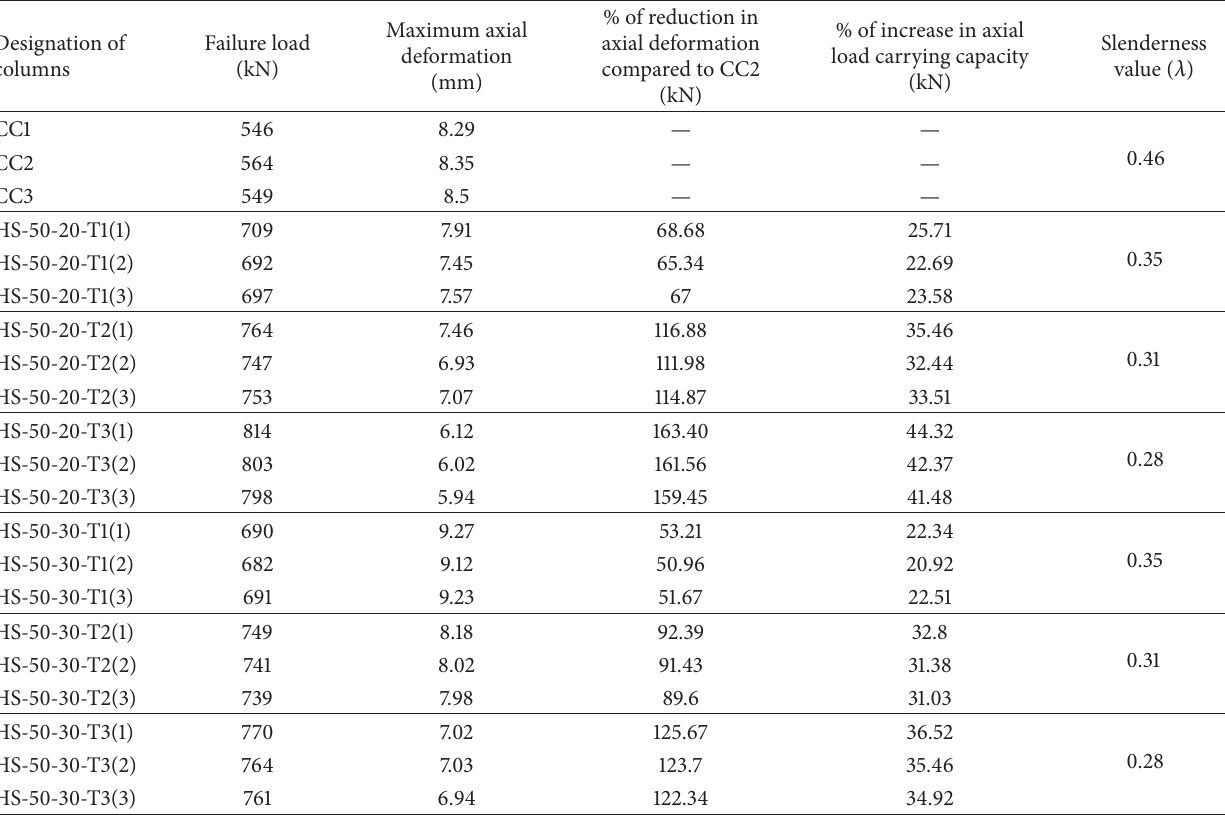
Table 1: Maximum deformation, percentage of reduction in deformation, and increase in load carrying